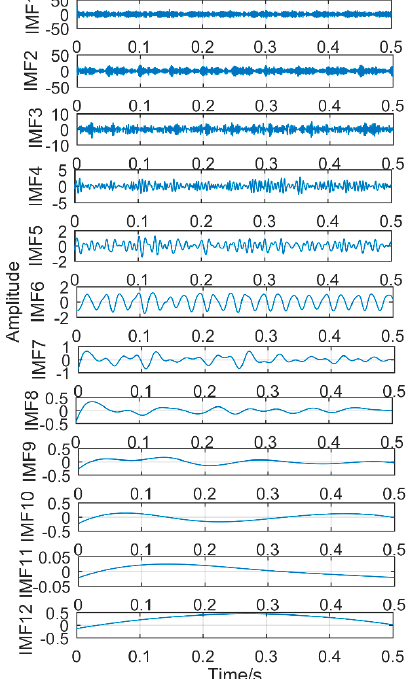
Figure 30. Time-domain diagram of decomposition results obtained by EEMD. Sensors 2018 , 18 , x FOR PEER REVIEW